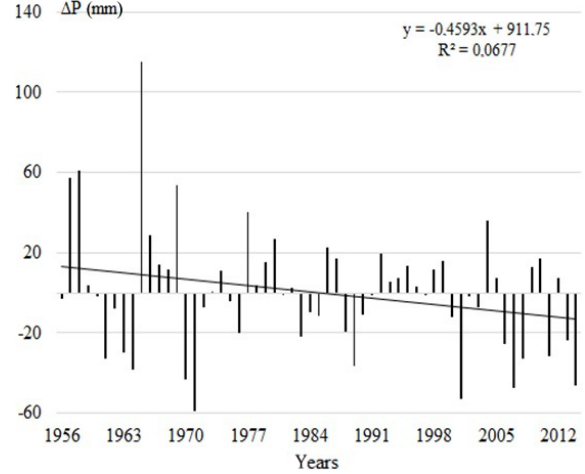
Figure 10. Deviation of annual precipitation from the long-term av- erage (1956–2012) and trend for the Bulunkul meteorological sta-